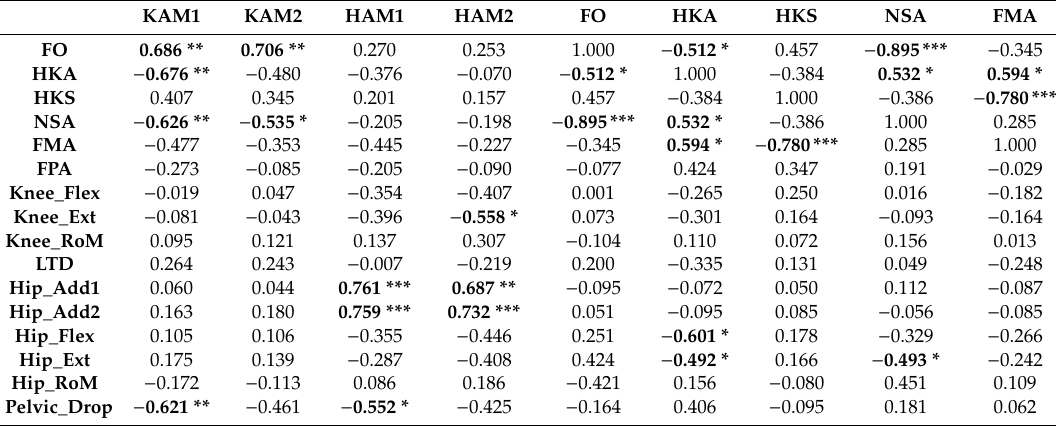
Table 4. Correlations between the joint adduction moments, joint kinematics, and the clinical leg parameters for the involved